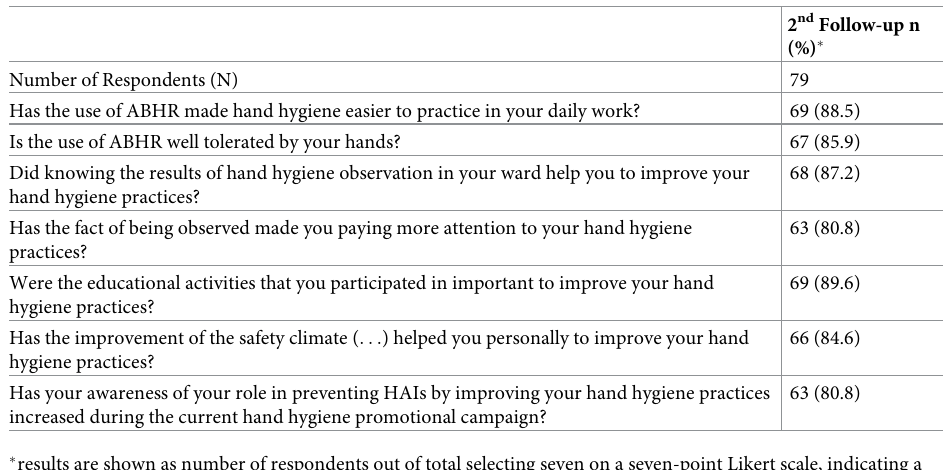
Table 4. HCWs’ perception about impact of